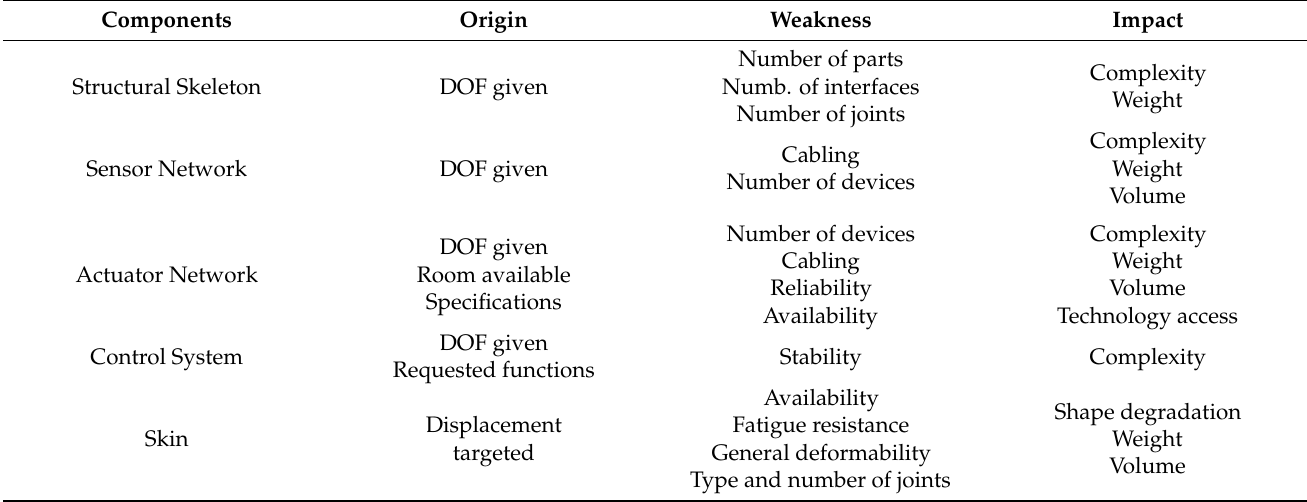
Table 1. Summary of weakness and criticalities of a morphing